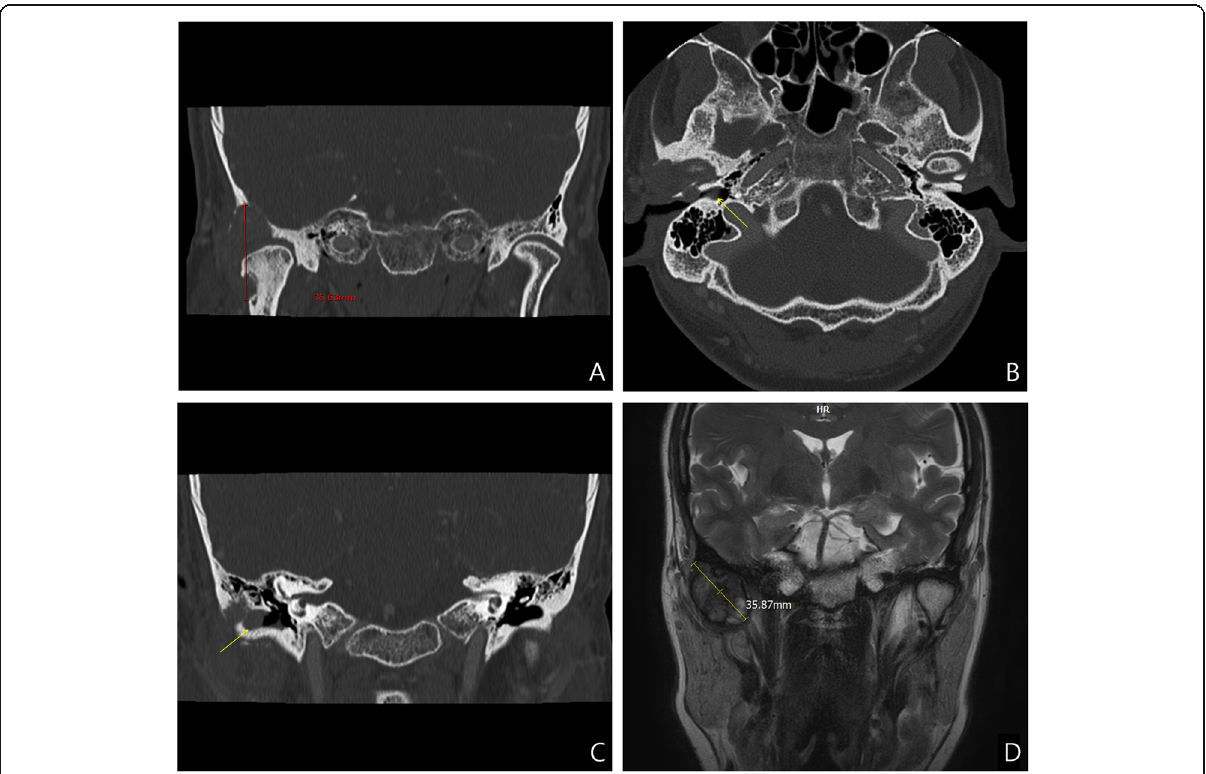
Fig. 1 Preoperative computed tomography A coronal view shows erosion of the skull base temporal bone and the moth-eaten appearance of the right mandible neck. The mild thickening of the tympanic membrane ( B , arrow) and fluid collection in the external auditory canal ( C , arrow) were tentatively diagnosed as external otitis due to an error in the interpretation of the images. Preoperative magnetic resonance imaging D coronal view shows an inhomogeneous, multi-lobulated mass with an intermediate